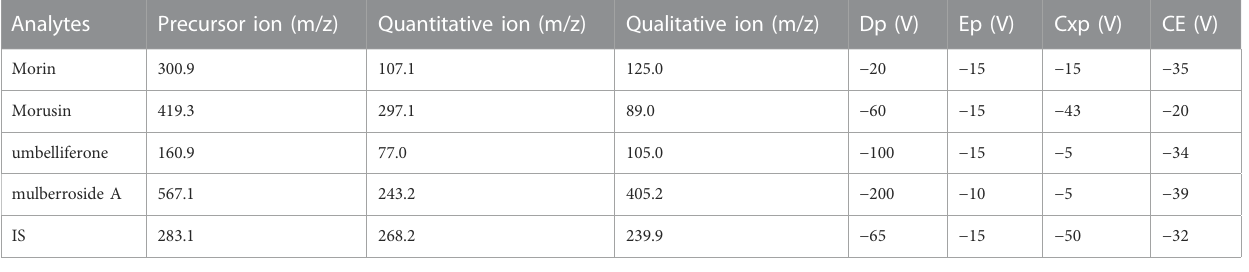
TABLE 1 Optimized mass parameters for analytes and IS. Analytes